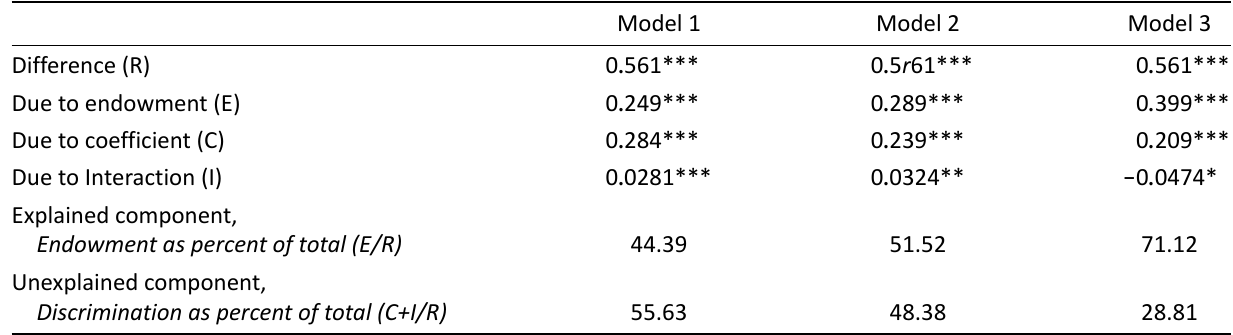
Table 4. Oaxaca‐Blinder decomposition results using male vs female mean labor income,